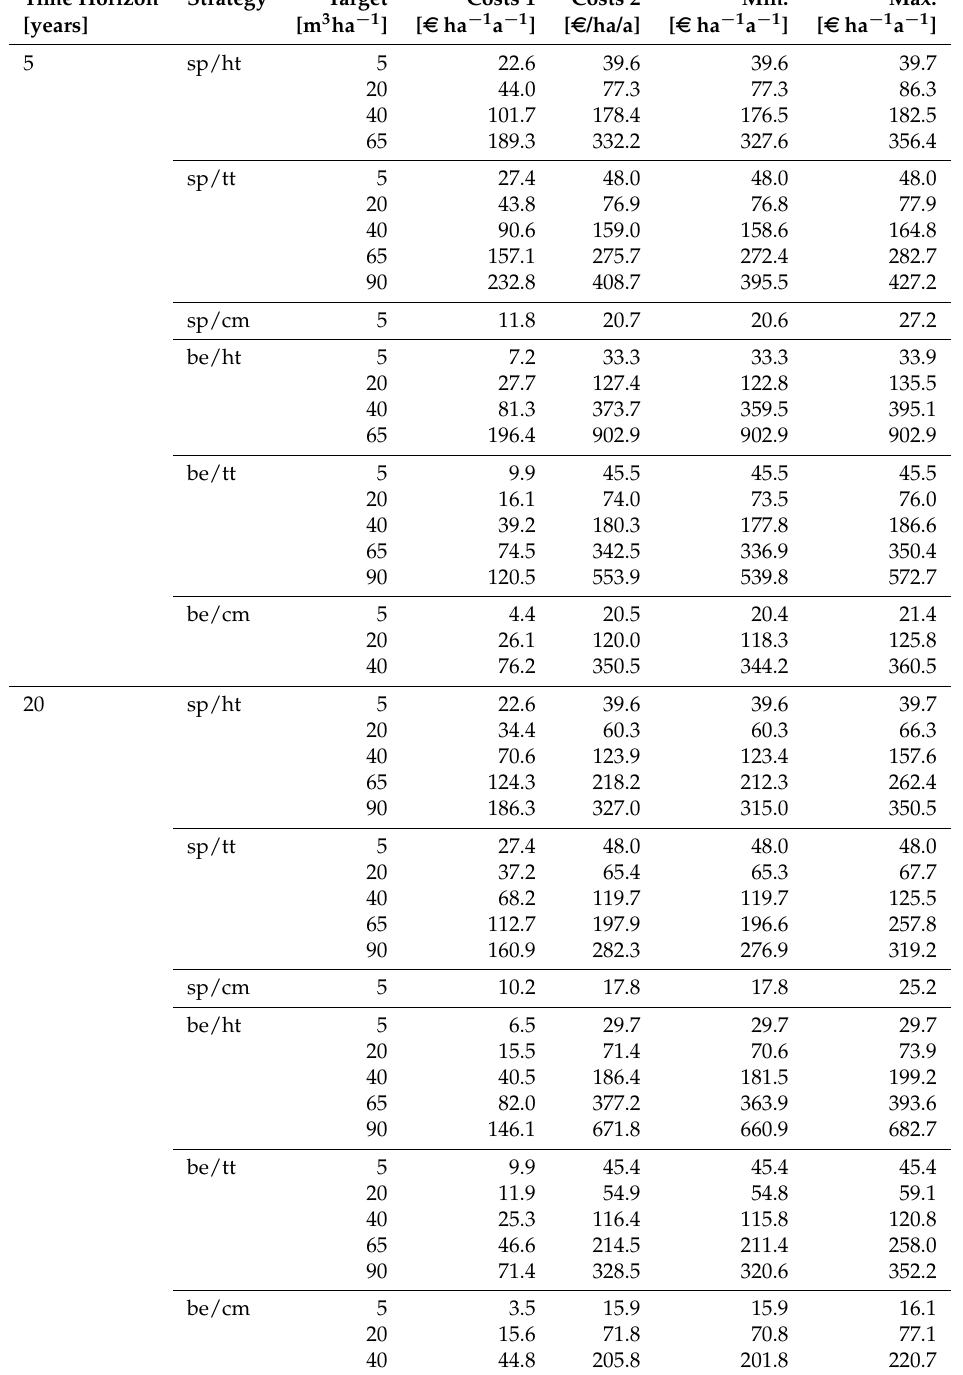
Table 4. Forest enterprise “Eichelberg”: Median costs and influence of the degree of segregation. The single strategies are abbreviated as shown in Table 3. Costs 1 shows the costs as the loss of annuity within the enterprise, while Costs 2 shows the costs related to the area of the individual tree species of the scenario. The Min. column shows the result for 100% segregation, the Max. column the result for 1%